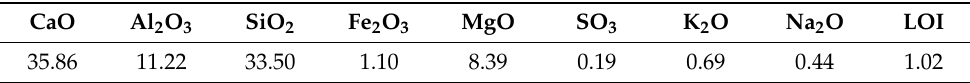
Table 1. Main chemical compositions of GBFS/wt.%.